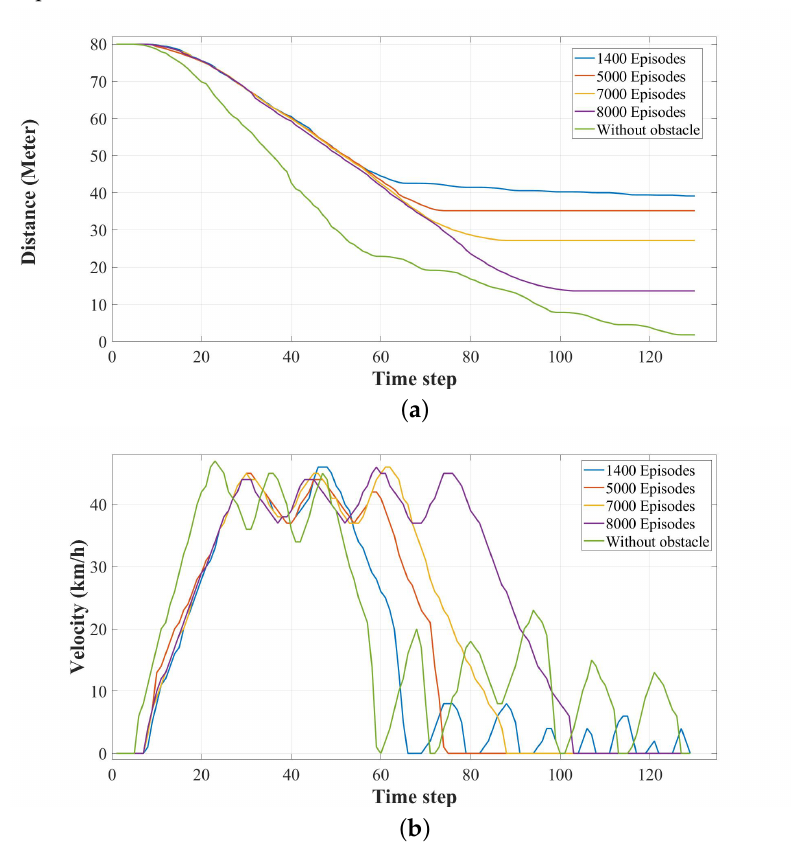
Figure 9. The motion of the agent relative to the number of training episode for straight motion test. ( a ) Distance from agent to destination. ( b ) Velocity of